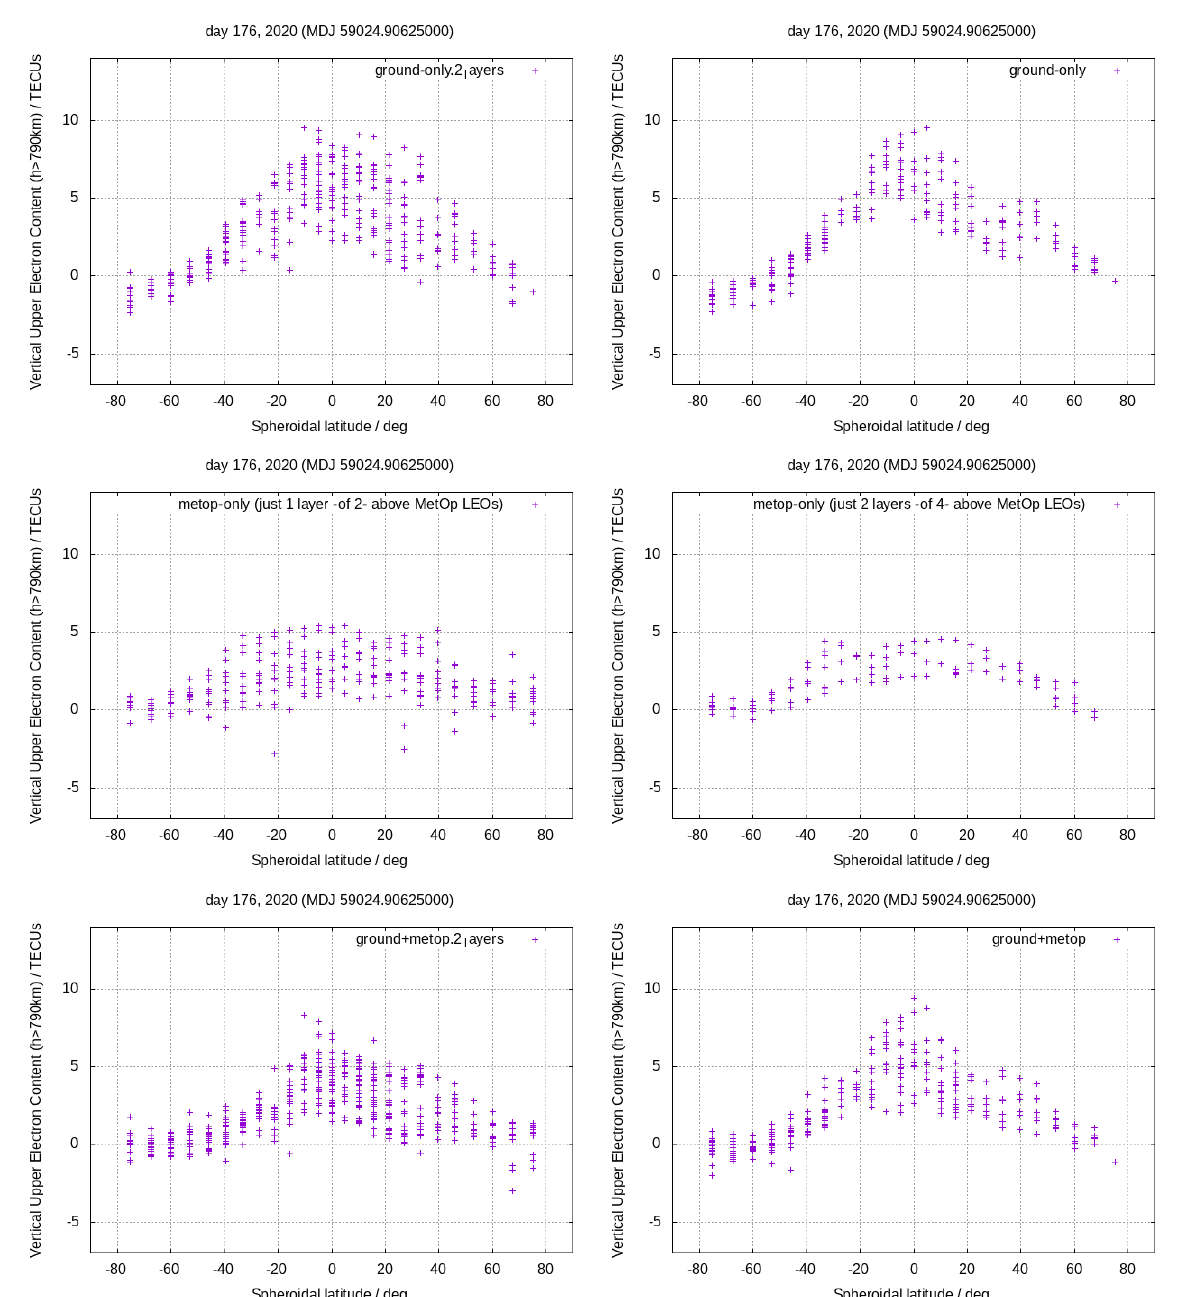
Figure 1. Comparison of the Vertical Upper Electron Content (in TECUs) vs latitude at GPS time 21 h 45 m of day 176 of year 2020, considering: ( left ) 2 layers (1 above MetOp LEO satellites) in the first column and ( right ) 4 layers (2 above MetOp LEO satellites) in the second one. The input measurements consist of ground GPS ground-based measurements only (first row), MetOp POD GPS measurements only (second row) and combined ground GPS and MetOP POD GPS measurements (third